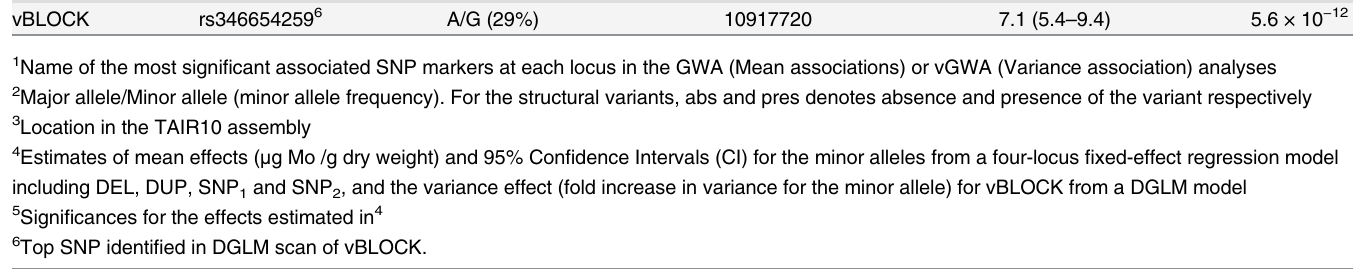
Table 1. Mean and variance effects for five loci in the MOT1 region associated with either mean molybdenum concentration levels (GWA) or vari- ance (vGWA). Locus SNP 1